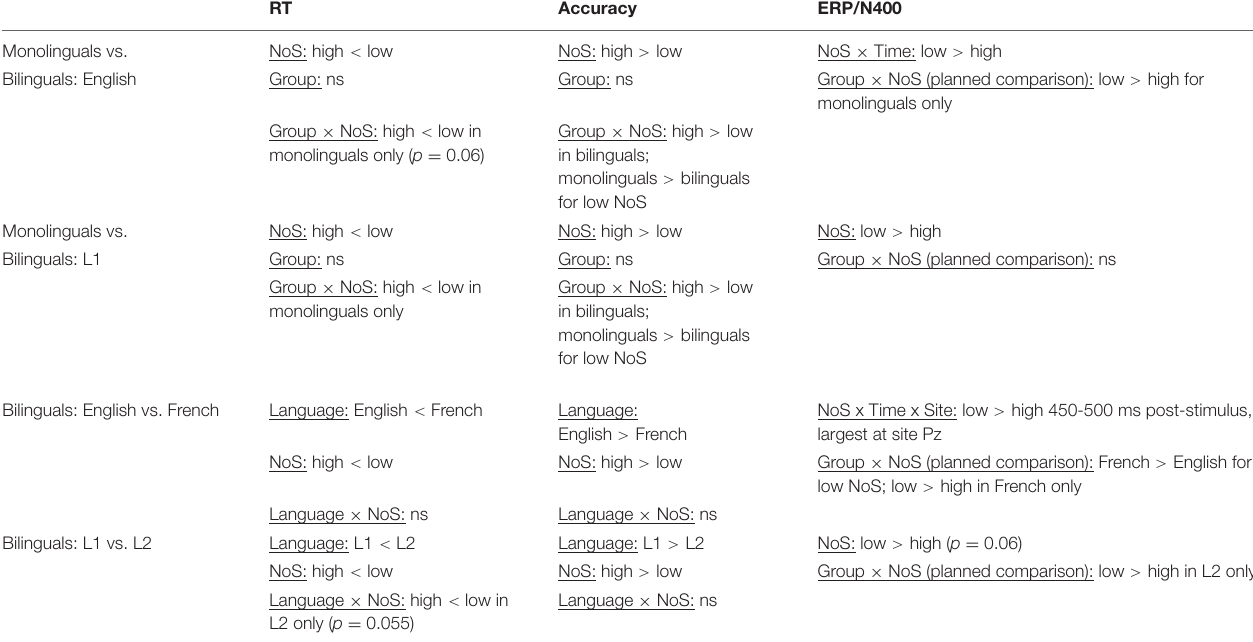
TABLE 6 | Summary of behavioral and ERP results. RT Accuracy ERP/N400 Monolinguals